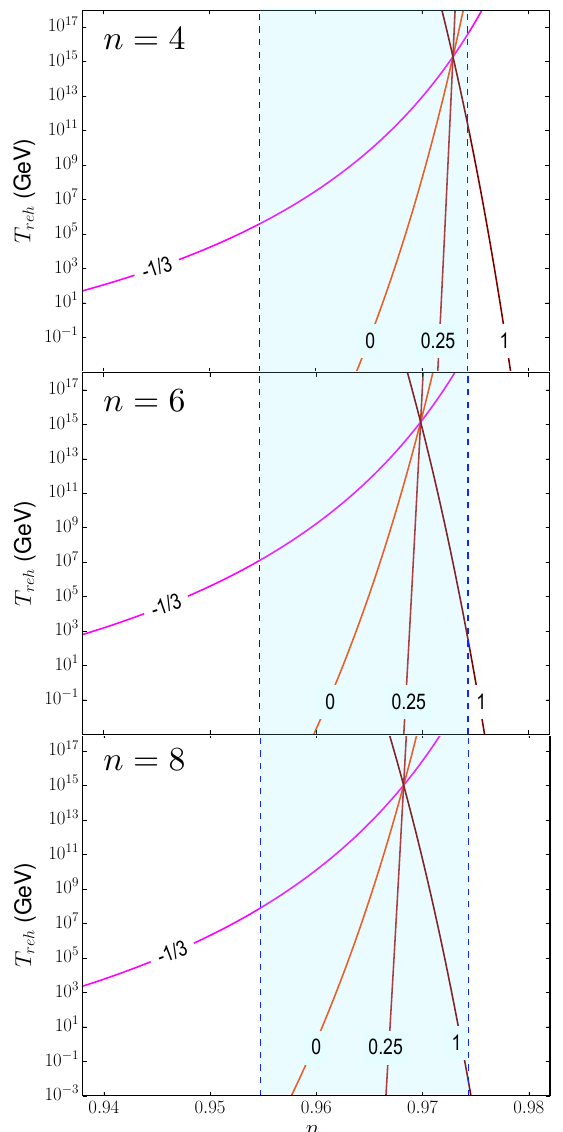
Figure 3. Predictions in the n s - T reh plane for the Generalised Gaussian Model (17) with n = 4,6,8, with α = 1. The shaded region shows Planck’s 2 σ constraint on n s . The curves intersect where reheating would occur